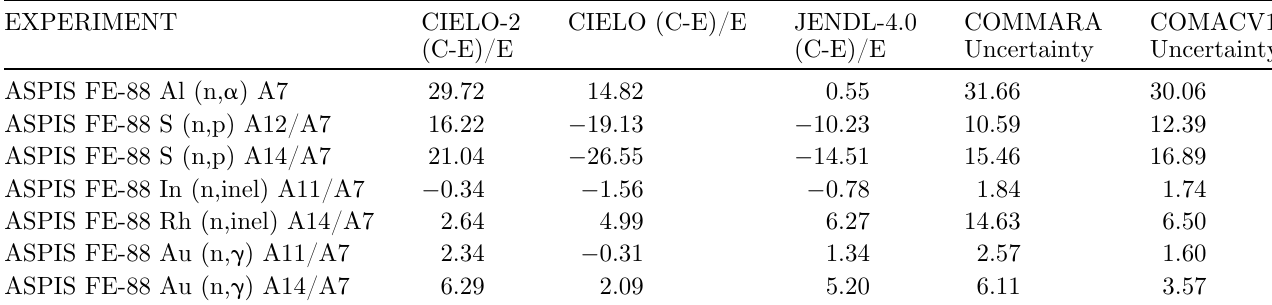
Table 6. (C-E)/E of CIELO and CIELO-2 isotopes and consistency with uncertainty of COMMARA 2.0 and COMACV1: ASPIS FE-88. (%).